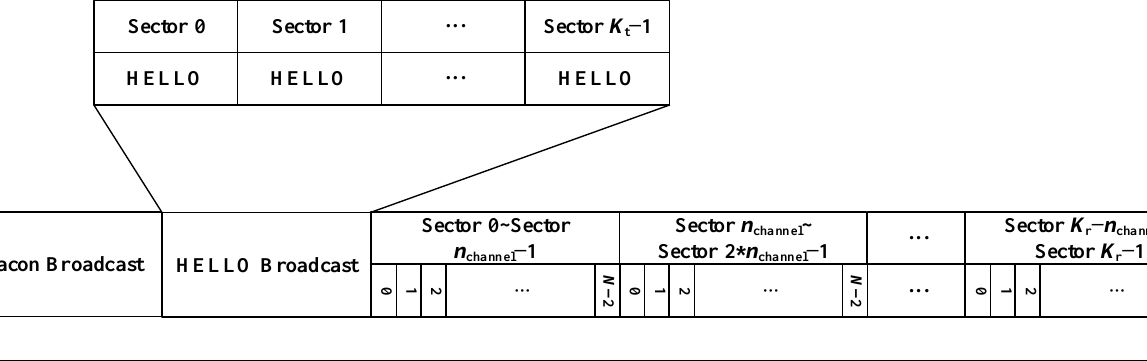
Figure 8. Fixed reply